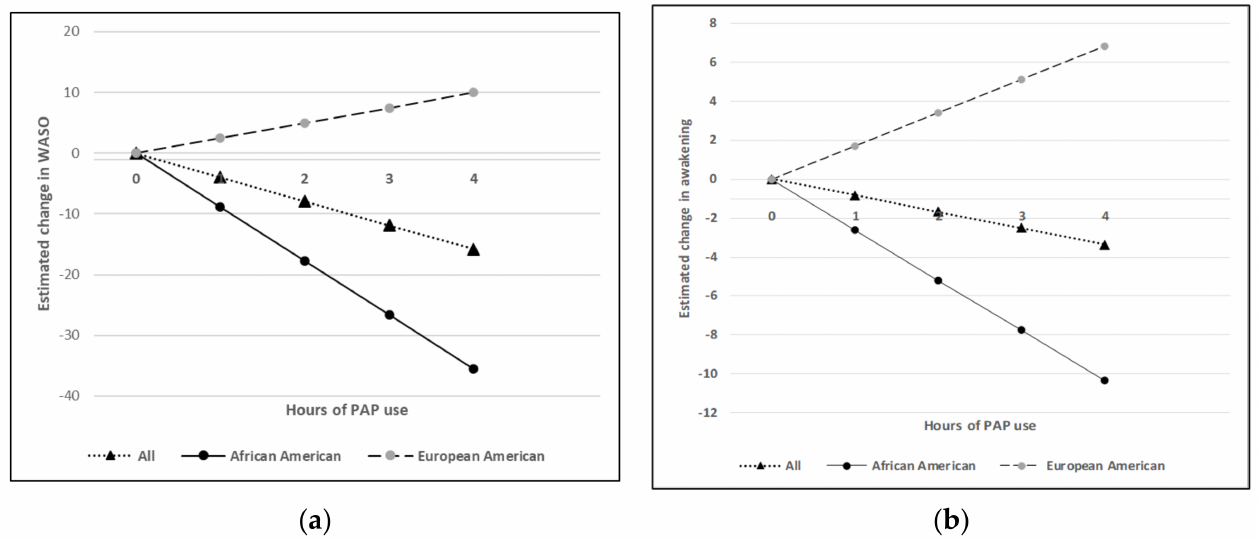
Figure 2. Estimated changes in outcome variables per 1 h increase in PAP use by each group: ( a ) Estimated changes in wake after sleep onset (WASO) per 1 h increase on positive airway pressure (PAP) use by each group; ( b ) Estimated changes in frequency of awakening per 1 h increase in PAP use by each